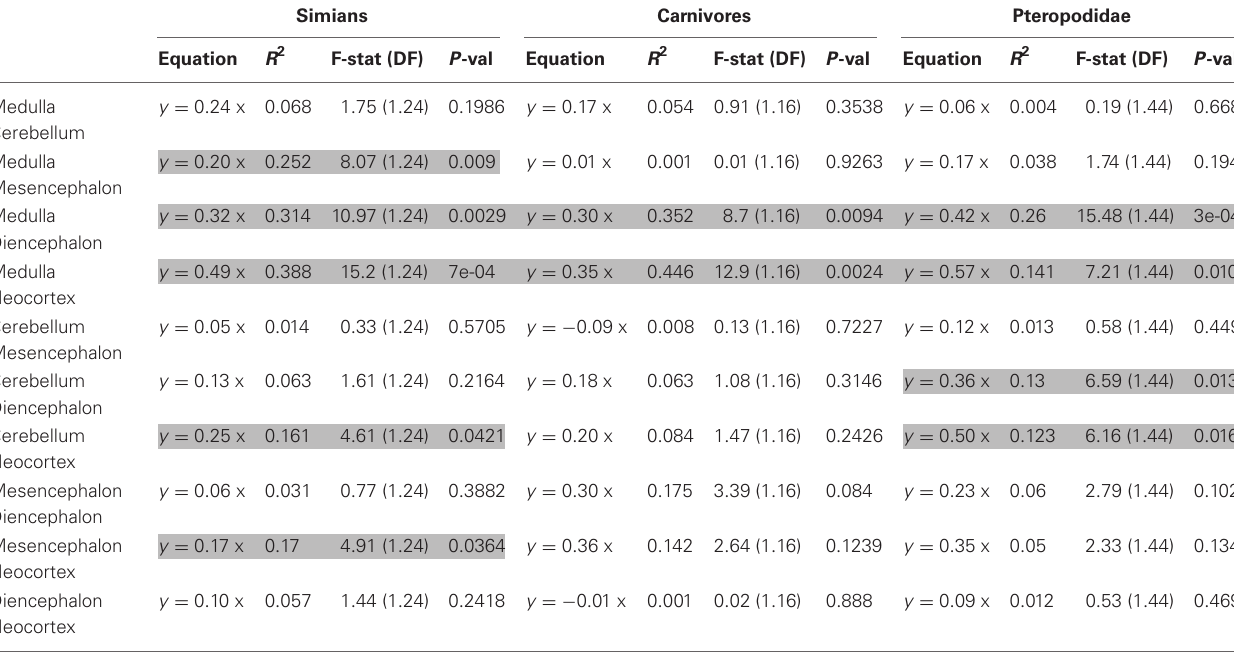
Table 2 | Results of regression of residuals of the size of one structure against the size of another structure onto encephalization residuals. Simians